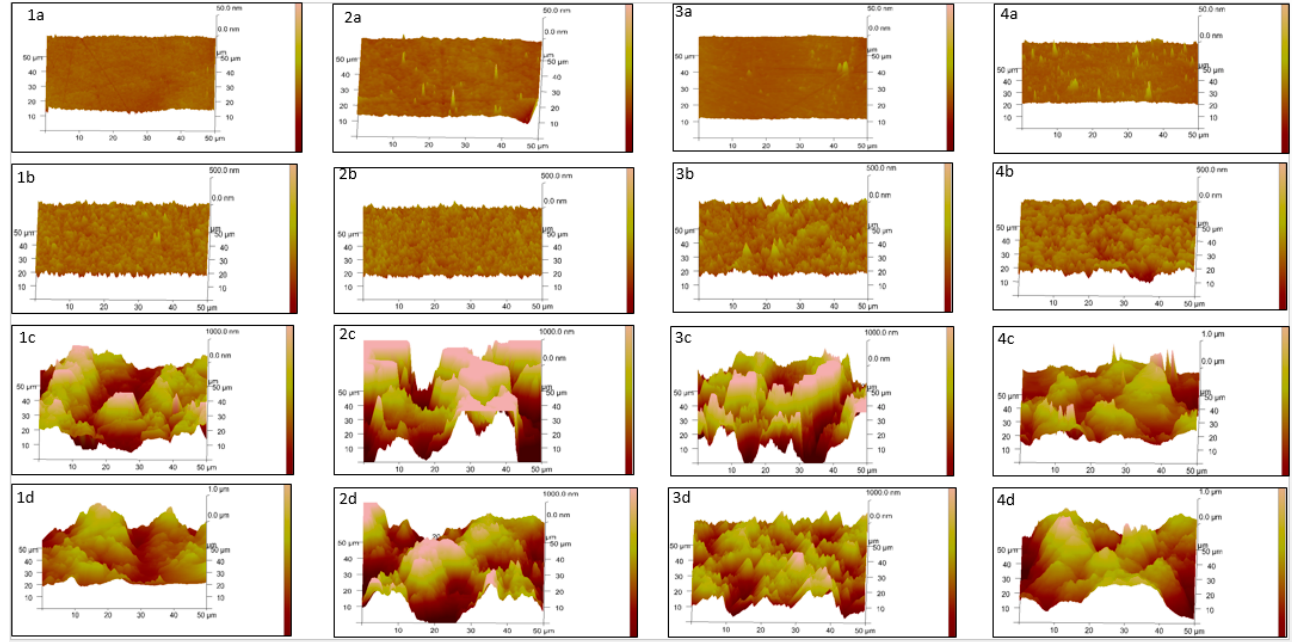
Figure 2. Atomic force microscopy images (AFM).). IPS e. max ® CAD ( 1 ) Vita Suprinity ® ( 2 ), Celtra Duo ® ( 3 ), n!ce ( 4 ). ( a ) Control, ( b ) HF, ( c ) SB, ( d ) SB + HF.